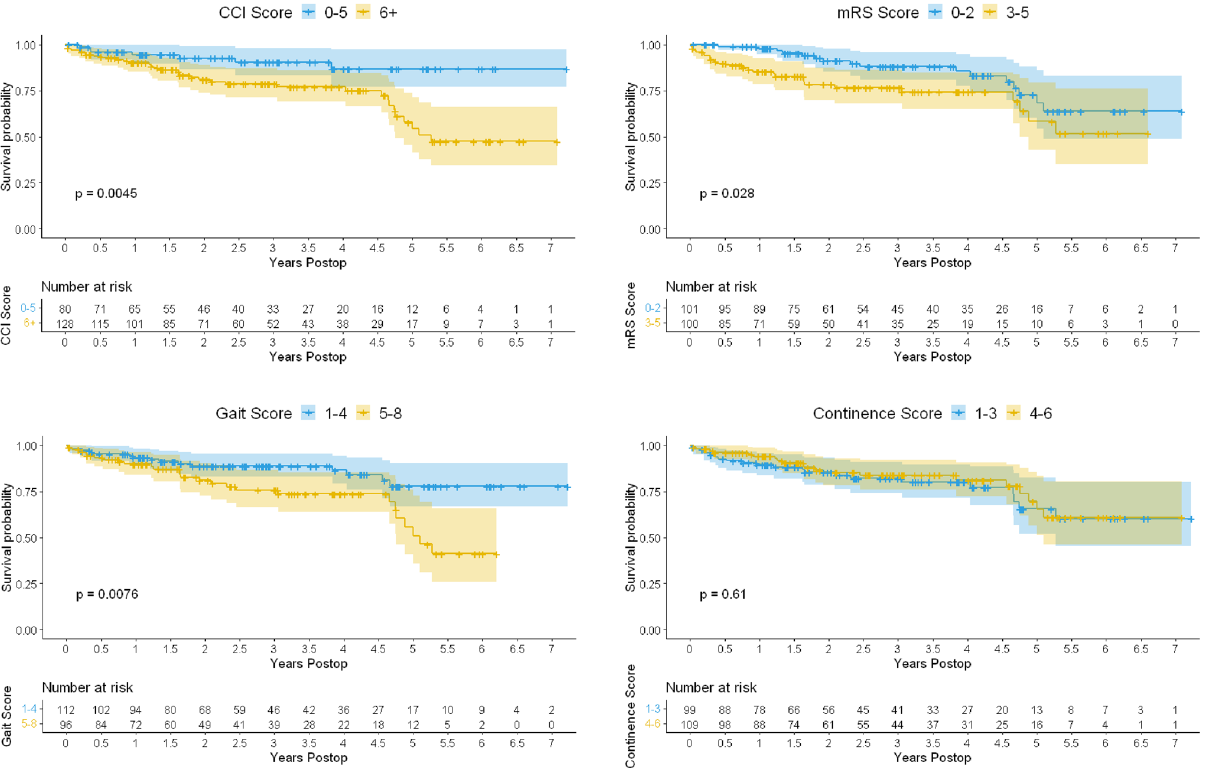
Figure 1. Kaplan–Meier analysis of survival time versus CCI, mRS, gait and continence score. The log rank test revealed significant differences between the low and high score groups of CCI, mRS and gait, but not continence score. The 95% confidence intervals and censoring of cases are